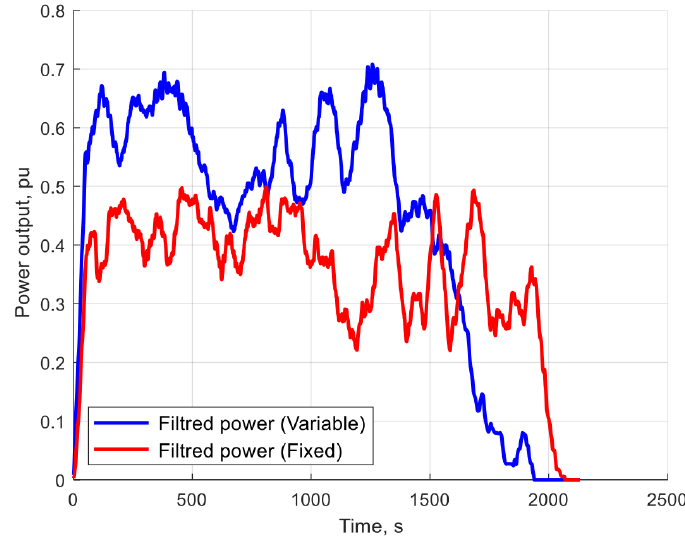
Figure 12. Filtered power generation curves for the first test, and in both fixed and variable pitch angle